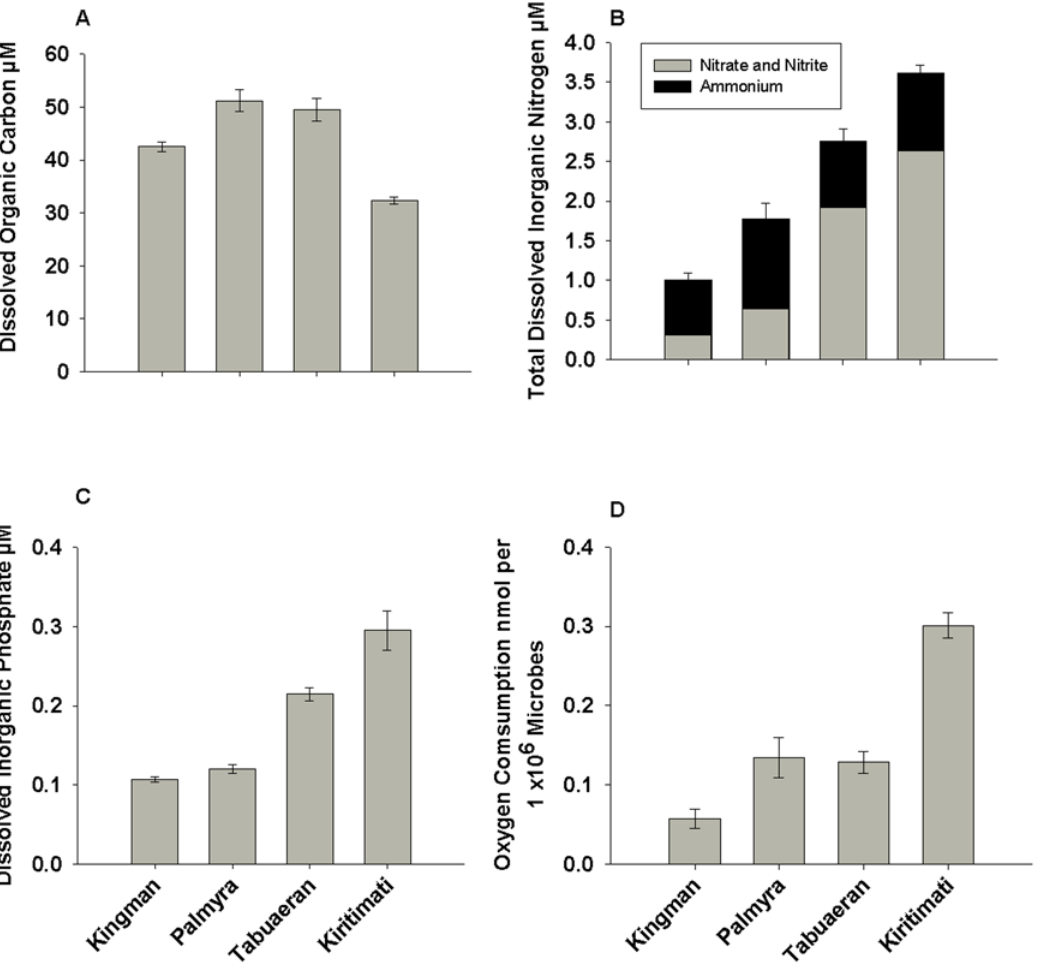
Figure 7. Water chemistry measured for the four Northern Line Island atolls. Concentrations of A) Dissolved organic carbon (DOC), B) Total dissolved inorganic nitrogen (TDIN: nitrite and nitrate, and ammonium), and C) Dissolved inorganic phosphate are presented as means ( 6 standard errors). D) Microbial respiration rates as determined by adding the same microbial communities to samples of seawater collected from the four atolls.